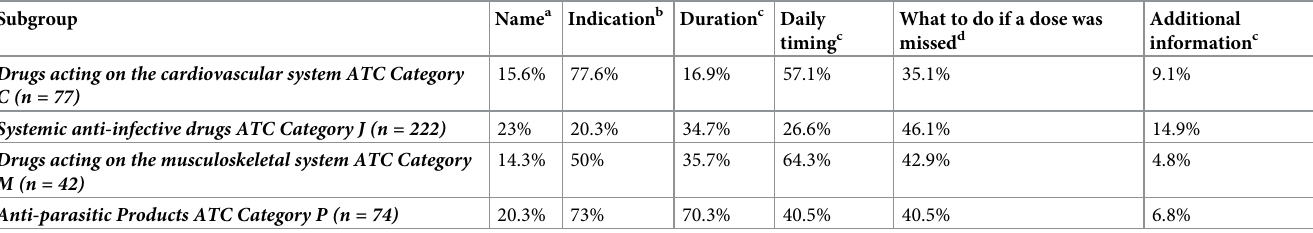
Table 5. Percentage of respondents with correct responses to questions assessing their medication knowledge of drugs in selected ATC categories.